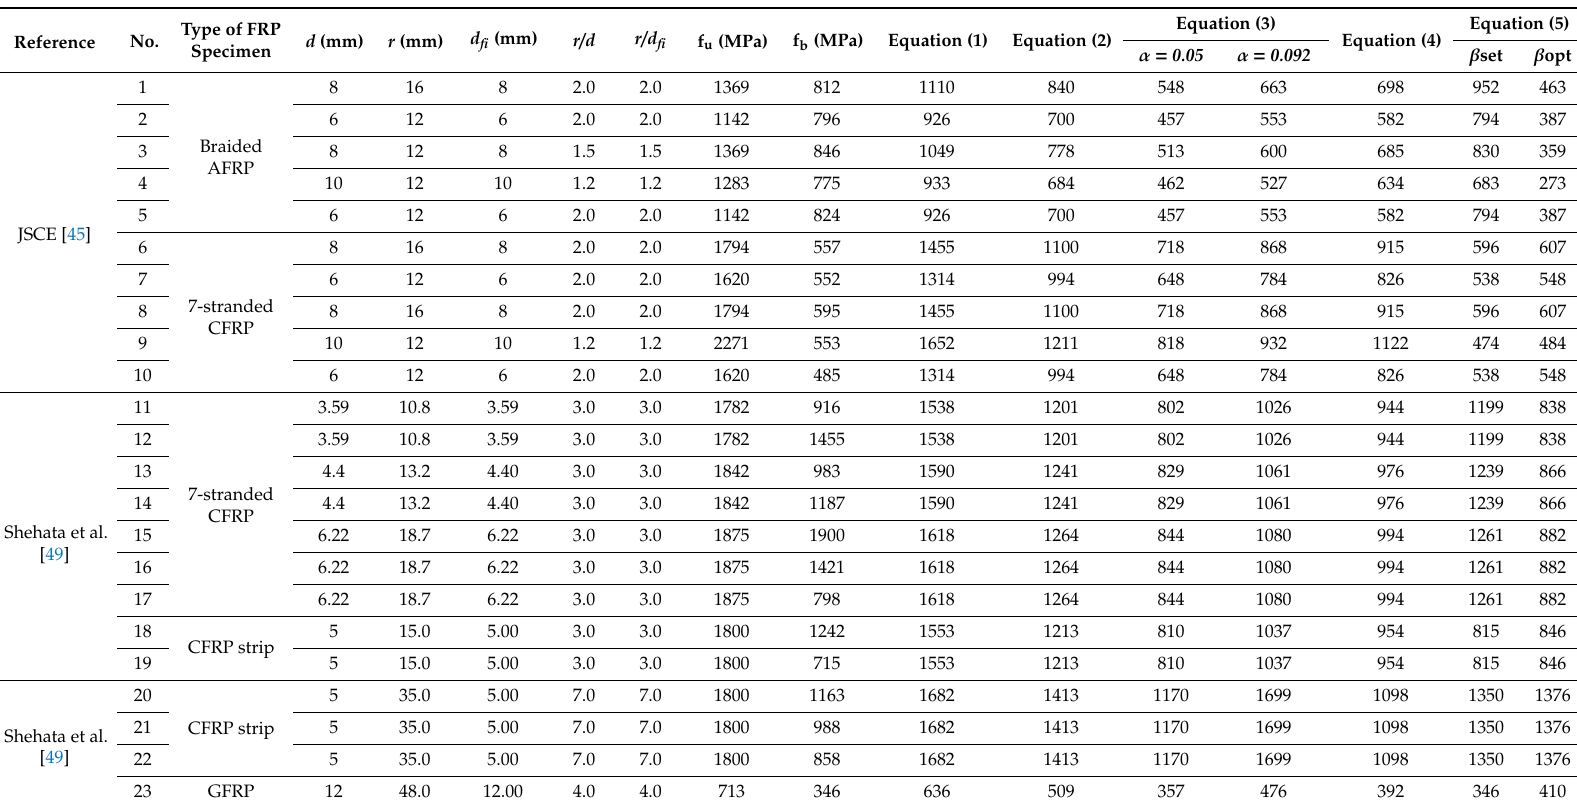
Table A1. Bent test data from